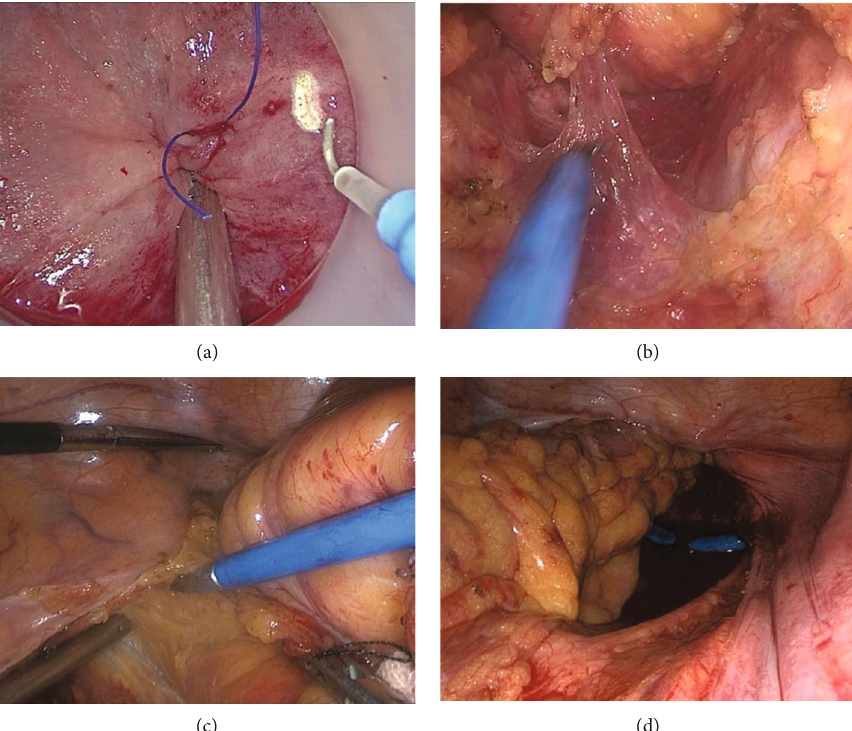
Figure 1: (a) Beginning of the purse-string suture. (b) Completion of TME by the opening of the peritoneum re fl ection. (c) Incision peritoneal re fl ection on the anterior lateral sided. (d) After cutting o ff the bowel at the distal tumor